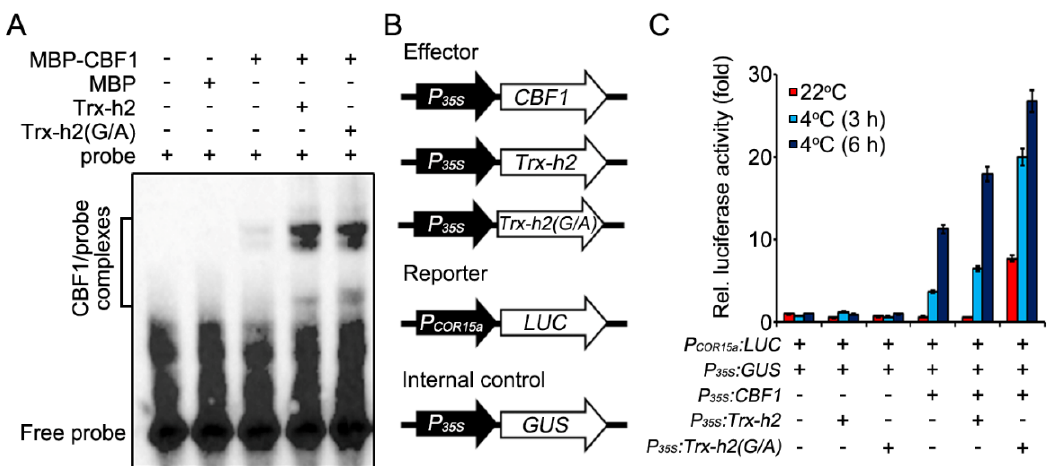
Figure 4. Effect of the Gly 2 residue of Trx-h2 on the reduction and dissociation of CBF oligomers into monomers at warm (22 ◦ C) and cold (4 ◦ C) temperatures. ( A , B ) Cold-induced structural switching of CBFs from the disulfide-bonded oligomeric state to the reduced monomeric CBFs in Col-0, trx-h2 , Trx-h2-YFP OE / trx-h2 , and Trx-h2(G/A)-YFP OE / trx-h2 plants incubated at 22 ◦ C ( A ) and 4 ◦ C ( B ) for 6 h. Proteins were separated on reducing (lower panel) and non-reducing (upper panel) polyacrylamide gels. Structural changes in CBFs were analyzed by Western blot analysis with anti-CBF antibody. Labels O and M on the right side of the Western blot indicate CBF oligomers and monomers, respectively. ( C ) Quantitative analysis of CBF monomers in panels ( A , B ) measured by densitometry and quantified by the ImageJ software. The intensity of CBF monomers was normalized first relative to that of RbcL and then relative to the value of Trx-h2(G/A) at 22 ◦ C shown in the last lane in panel ( A ), which was set to 1. Data represent mean ± s.e.m. ( n = 3 biologically independent samples).